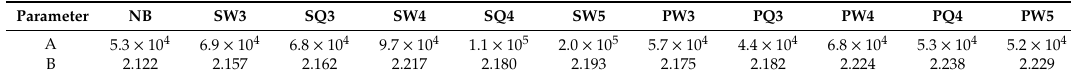
Figure 12. Results of LAS tests—fatigue lines: ( a ) SBR-modified binders; ( b ) PBR-modified binders. Table 7. Fitting parameters of fatigue